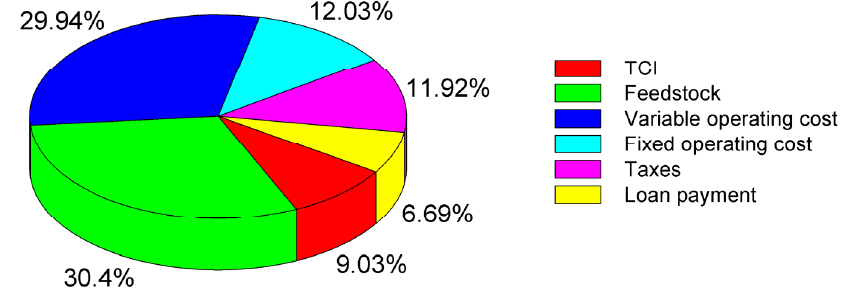
Figure 7. Cost breakdown by composition in scenario CN_1.